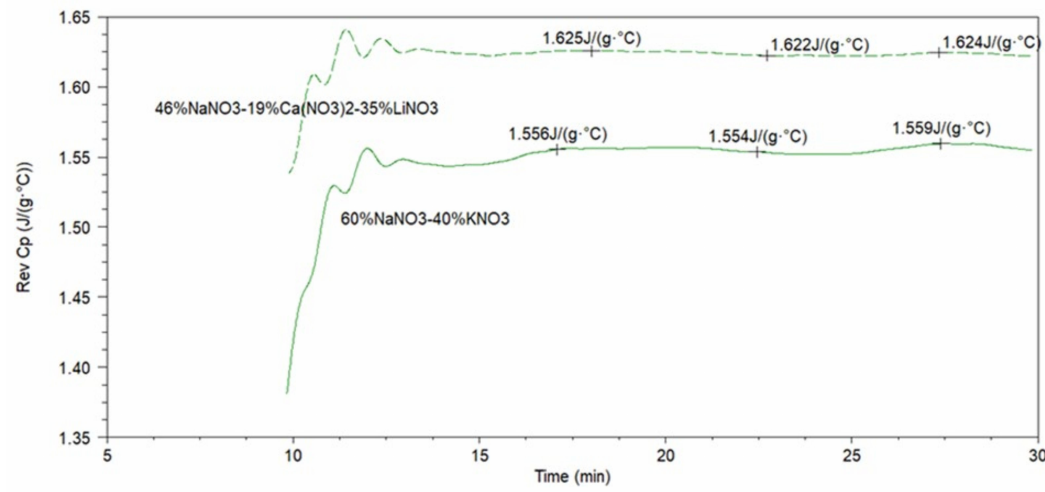
Figure 2. ( a ) 60% NaNO 3 -40% KNO 3 DSC curve; ( b ) 60% NaNO 3 -40% KNO 3 TGA curve. Generally, authors assign a working temperature range of 240 ◦ C–565 ◦ C [45]. The average specific heat capacity at 500 ◦ C was 1.55 J/g ◦ C (see Figure 3), in line with other investigations [46].